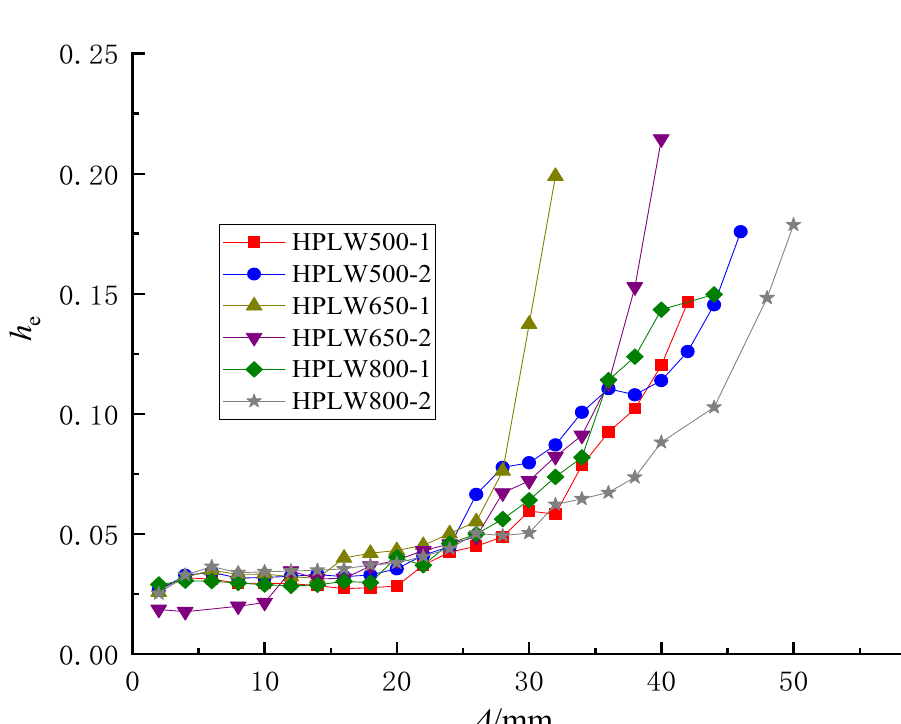
Figure 13. Equivalent viscous damping coefficient of viscous damping.